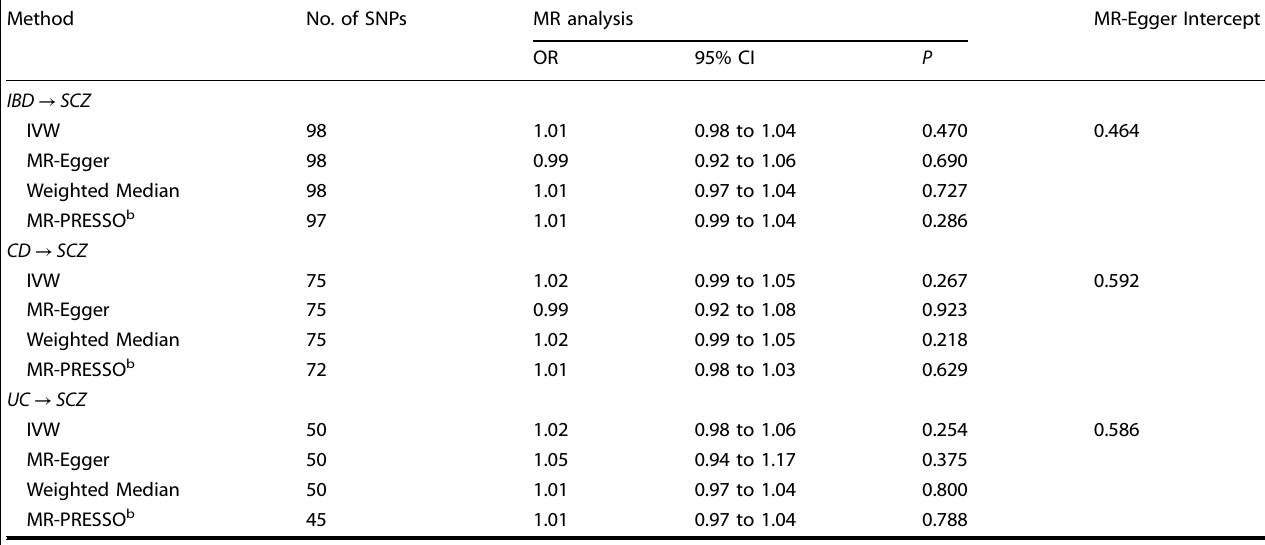
Table 2. Reverse Mendelian randomization estimates for causal effects of genetically predicted IBD and its subtypes on SCZ. Method